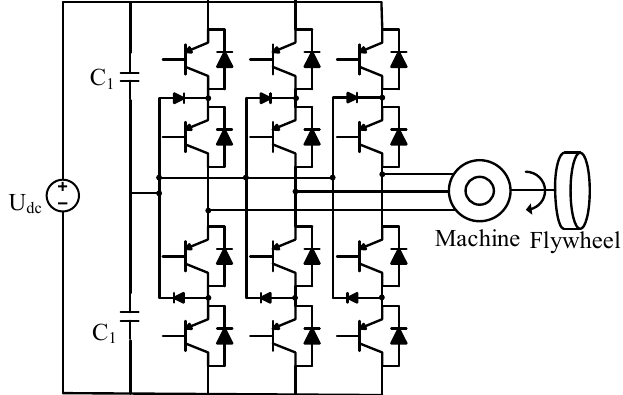
Figure 26. Topology of multilevel inverter with flywheel.